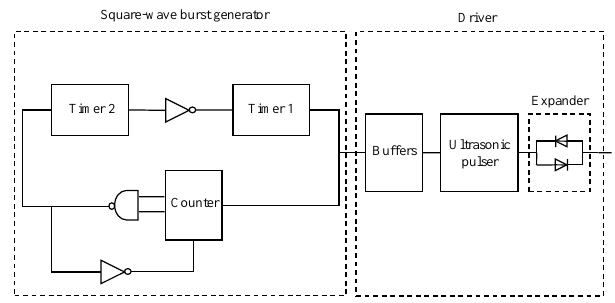
Figure 6. Simplified diagram of the pulser circuit.